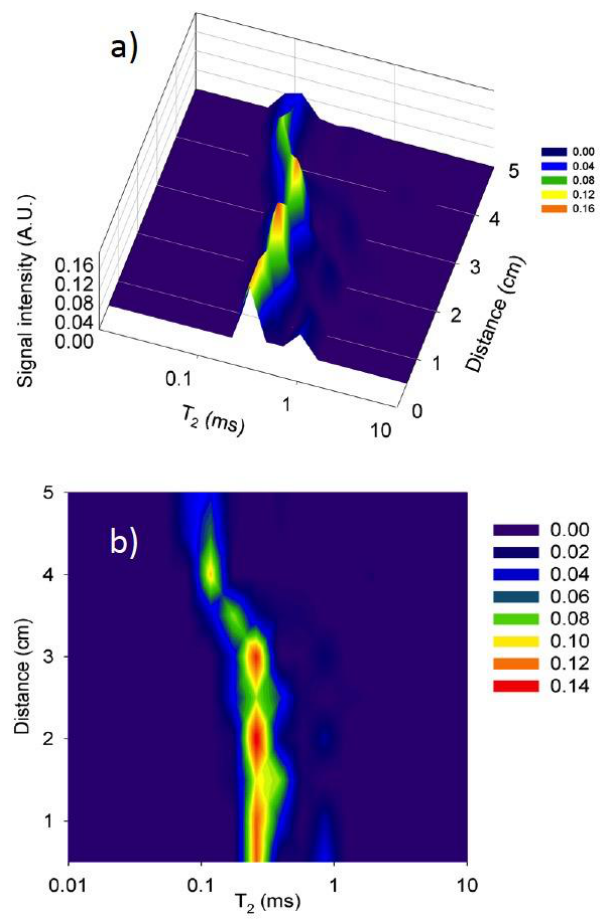
Figure 9. T 2 lifetime distributions along the length of a 0.60 w/c ratio mortar sample obtained by inverse Laplace transformation of the CPMG decays from the mortar sample shown in Figure 8a, at 2 days of water absorption: ( a ) 3D view and ( b ) 2D view.